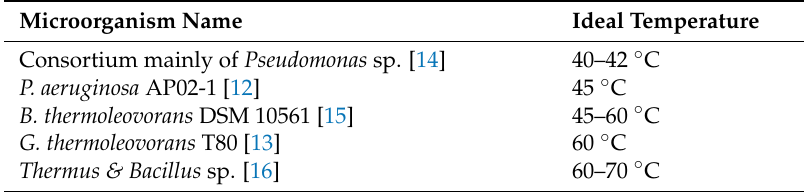
Table 2. Potential microorganism for hydrocarbon